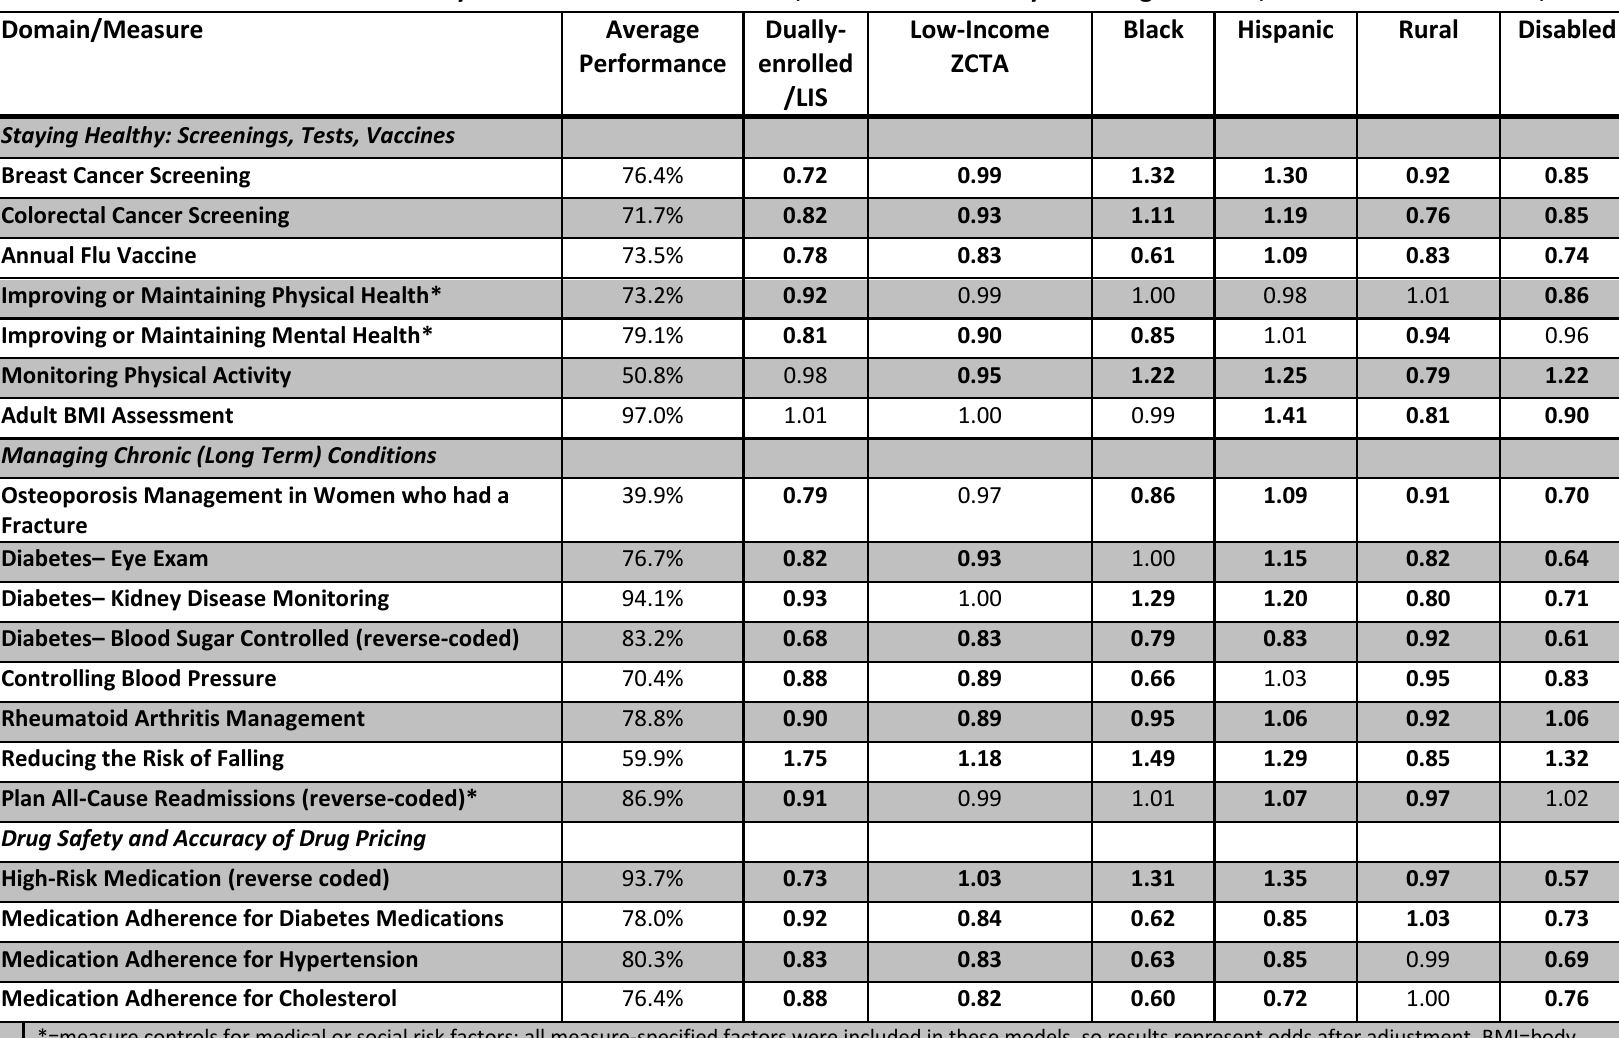
Table 8.3: Social Risk and MA Beneficiary-Level Measure Performance, Odds of Successfully Attaining Measure, Within-Contract Effects, 2014